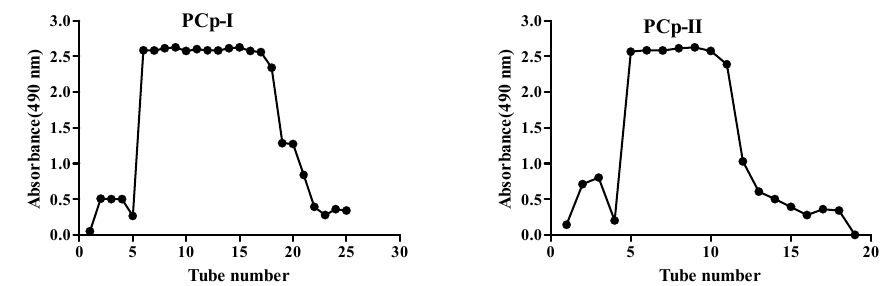
Figure 2. Sephadex G-100 chromatography of PC-I and PC-II.